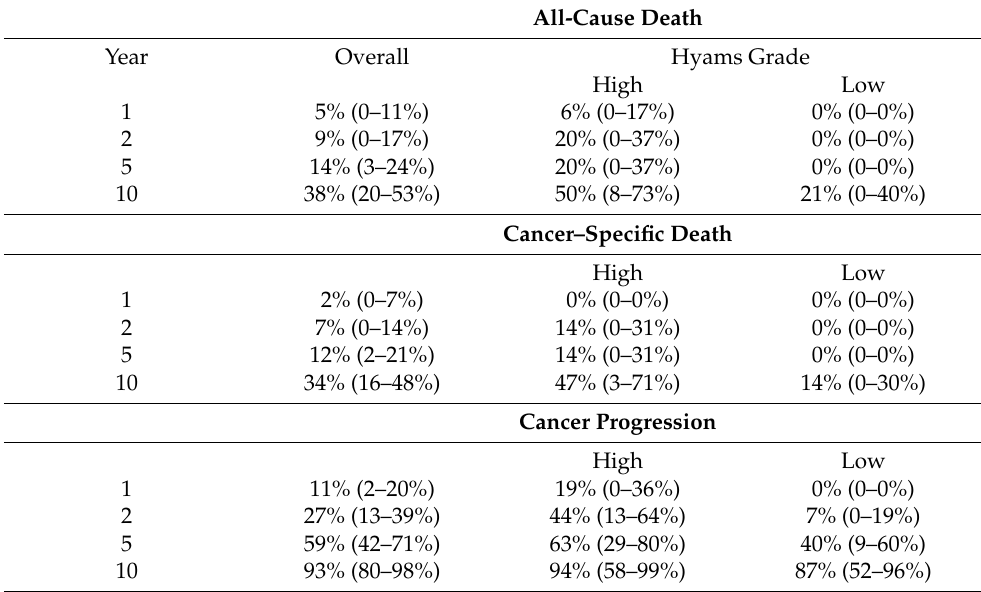
Table 7. The 1-, 2-, 5-, and 10-year cumulative incidence of all-cause death, cancer-specific death, and cancer progression after primary tumor diagnosis.